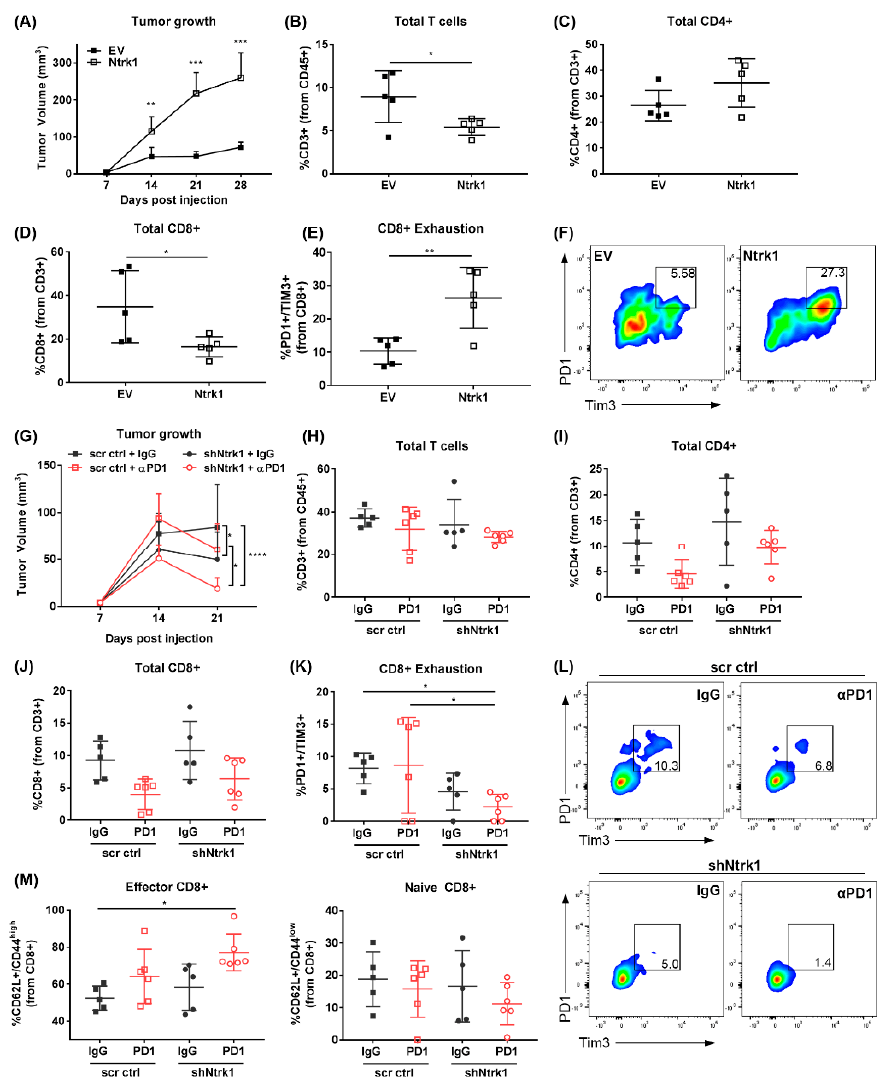
Figure 4. Ntrk1 modulates tumor growth as well as CD8+ T cell exhaustion and activity in vivo. ( A – F ) 393P EV and Ntrk1 cells were implanted subcutaneously into 129/sv wildtype mice. After 4 weeks of growth, tumors were collected and processed for flow cytometry analysis of immune cell populations. n = 5 mice/cell line. ( A ) Tumor growth was monitored weekly via caliper measurements. ( B ) The percentage of CD3+ T cells in the microenvironment was gated from live CD45+ cells. ( C ) CD4+ T cells were calculated as a percentage of total CD3+. ( D ) CD8+ T cells were calculated as percentage of CD3+ T cells. ( E ) T cell exhaustion was measured as PD-1+/TIM3+ from the CD8+ population. ( F ) A representative dot plot of PD1+/TIM3+ T cells from each condition. ( G – M ) 344P cells with stable depletion of Ntrk1 were implanted subcutaneously into 129/sv wildtype mice and compared to a non-targeting control cell line. One week post-implantation, tumors were then treated with either IgG control or PD-1 blocking antibody for 2 weeks, at which point tumors were collected and processed for flow cytometry analysis. ( G ) Tumor growth was monitored weekly via caliper measurements. ( H ) The total CD3+ T cells was quantified from total live CD45+ cells in tumors. ( I ) CD4+ T cells were calculated from total CD3+ cells. ( J ) CD8+ T cells were quantified as a percentage of total CD3+ T cells. ( K ) PD-1+/TIM3+ exhausted T cells were calculated as described in panel E. ( L ) Representative dot plots from each condition showing PD1+/TIM3+ T cells. ( M ) Effector (left graph) and naïve (right graph) CD8+ T cells were calculated as a percentage from total CD8+ T cells. Effector cells were characterized as CD62L+/CD44high and naïve cells as CD62L+/CD44low.